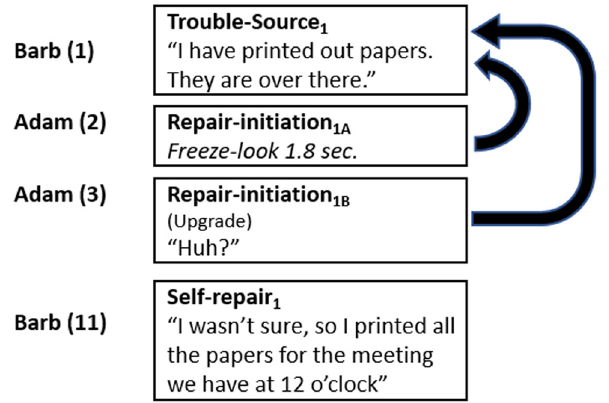
Figure 13: Multiple OIR sequences where the same trouble source is targeted more than once.